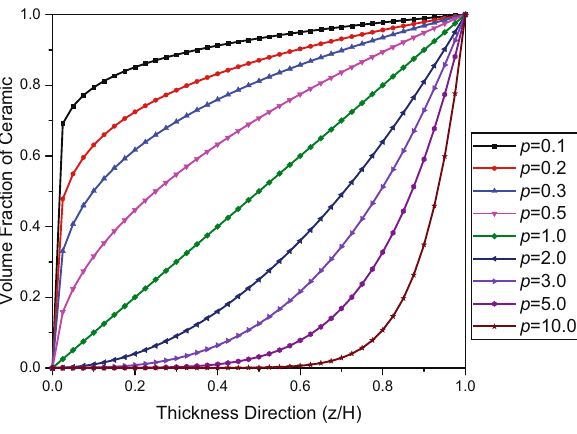
Figure 2: Volume fraction of ceramics under di ff erent gradient parameters.